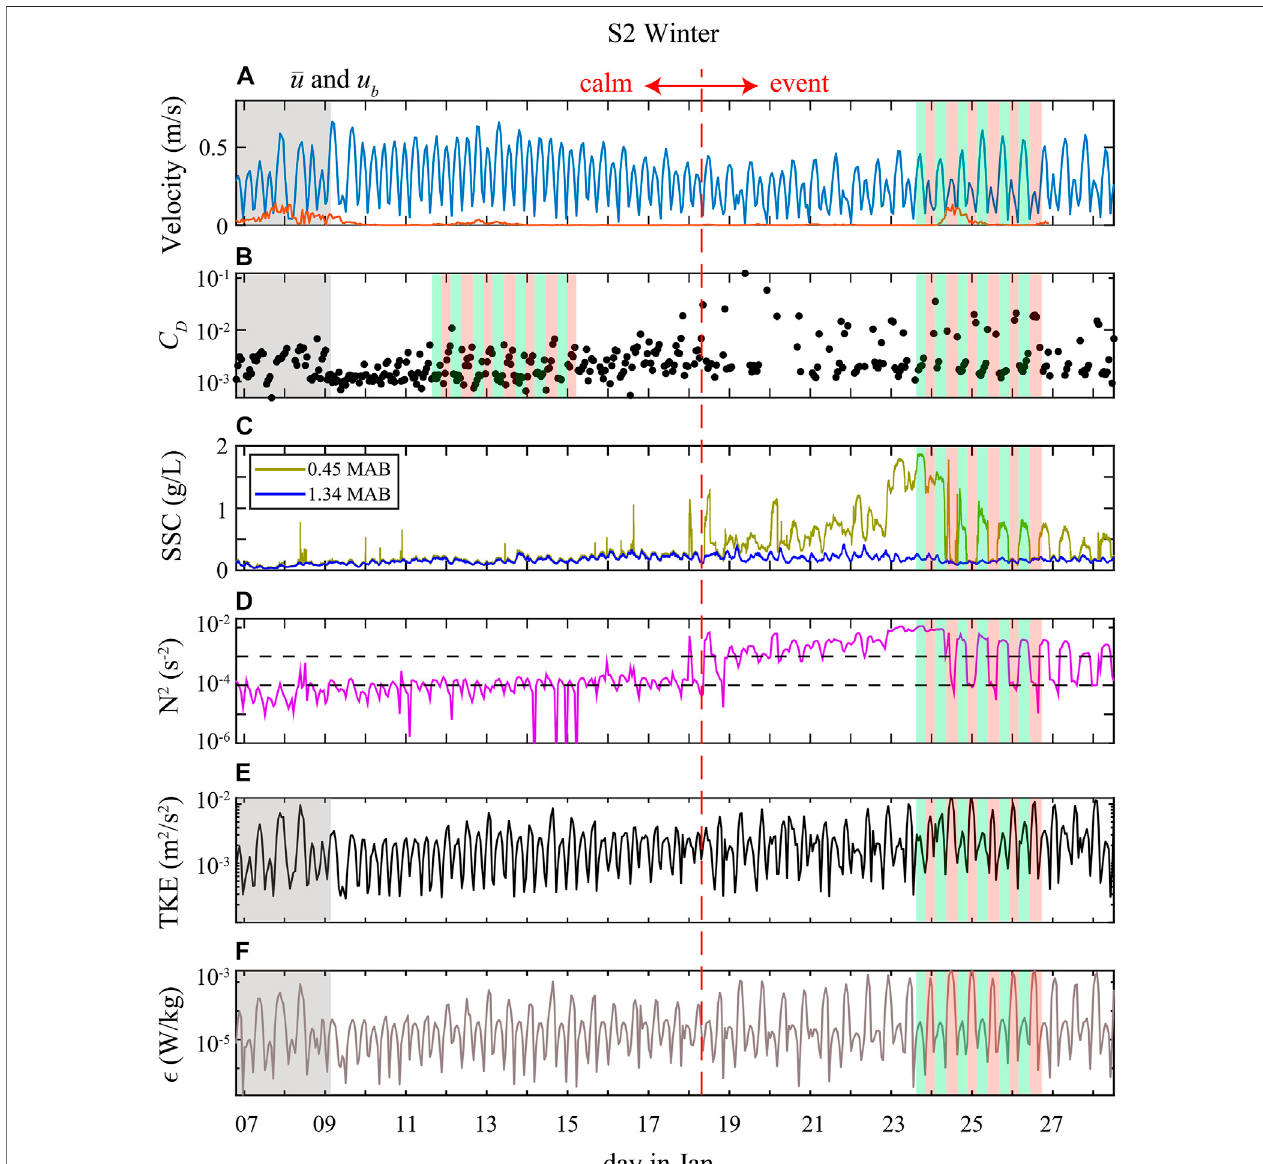
FIGURE 8 | Twenty-day time series during the winter deployment at S2 showing measurements of (A) ADV ’ s burst mean velocity ( (cid:1) u , blue line) and bottom wave orbital velocity ( u b , orange line), (B) drag coef fi cient, C D , estimated using ADV ’ s burst mean velocity, (C) suspended sediment concentration (SSC) at 0.45 mab (yellow line)and1.34mab(blueline), (D) buoyancyfrequency( N 2 )andtheblackdashedlineindicates N 2 isequalto10 − 3 s − 2 ,and10 − 4 s − 2 , (E) turbulentkineticenergy(TKE)and (F) turbulence dissipation rates ( ε ). Green and red shaded areas denote periods of ebb and fl ood tides, respectively, and gray shaded areas denote periods of strong winds. The vertical red dashed line is the demarcation between the calm and event periods.